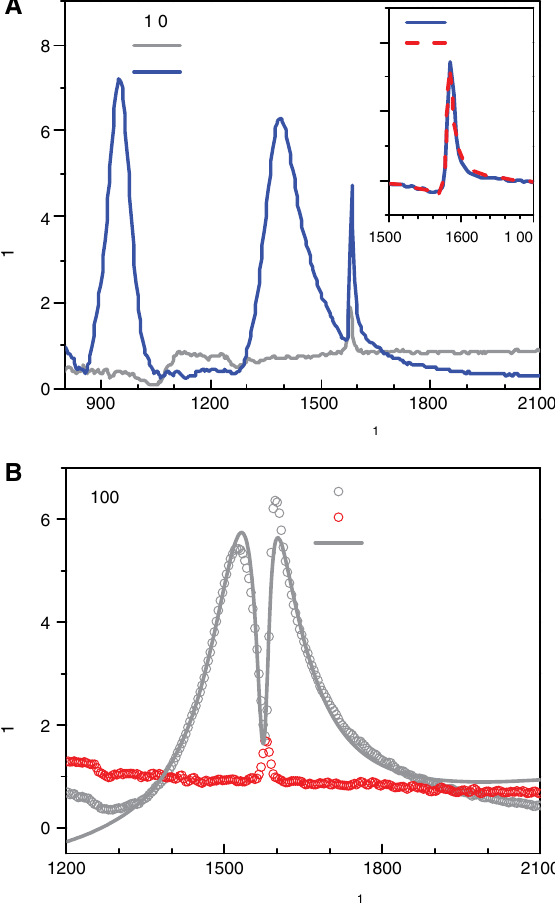
nanoribbon array (Figure 6B) and electrodes for back- gating were also fabricated (Figure 6A). With the nanor- ibbon width in the order of ∼ 100 nm, the plasmon frequency is in the mid-infrared. Figure 7A shows the absorption spectra of a bilayer graphene nanoribbon (width W = 130 nm) array with light polarization paral- Figure 7 Phonon-plasmon Fano resonance system. (A) The infrared lel and perpendicular to the ribbons. Without plasmon spectra of a nanoribbon array with ribbon width 130 nm for parallel excitation (parallel polarization), only a phonon absorp- and perpendicular polarizations. Inset shows the extracted phonon tion peak is observed in a broad featureless spectrum. spectrum and a Fano fitting. (B) The typical spectrum for phonon- However, with the excitation of the plasmon (perpen- induced transparency (gray dots). The gray solid curve is a fitting dicular polarization), multiple peaks can be observed based on the coupled oscillator model (A–B adapted with permis- and the phonon feature amplitude is largely enhanced. sion from [56], Copyright 2014 American Chemical The lineshape of the phonon shows strong asymmetry and can be fitted with a Fano resonance model (inset of Figure 7A). As seen from the spectrum for parallel polarization, the phonon peak has very little asym- metry without excitation of plasmons for those bilayer samples studied by Yan et al. The excitation of plasmon with a frequency nearby strongly affects the phonon behavior and the phonon-plasmon coupling dominates the phonon appearance. The two broader peaks(not the phonon peaks) shown in the spectrum of Figure 7A for the perpendicular polarization are the plasmon modes from bilayer graphene. More precisely, they are plas- mon-phonon-polariton modes which are resulted from the hybridization of the graphene plasmon mode with the surface polar phonon modes of the SiO substrate 2 [47, 52, 53, 61].